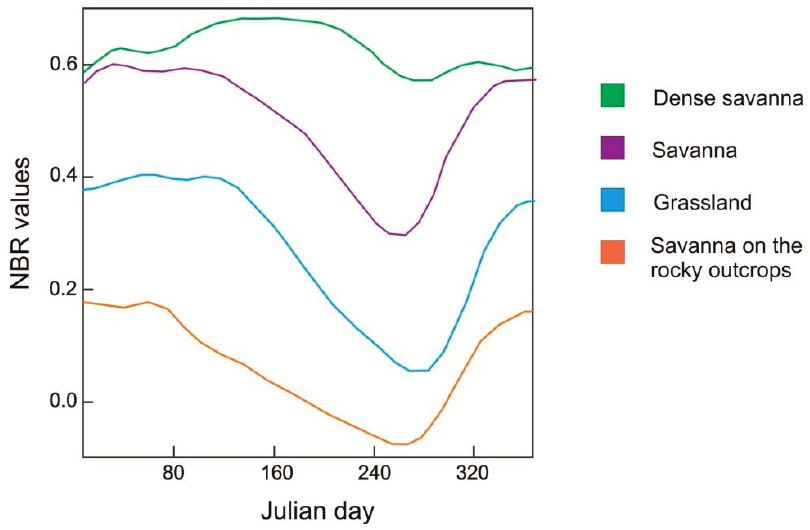
Figure 15. Mean annual curves of the savanna types: Savanna on rocky outcrop, Grassland, Savanna and Dense Savanna Woodland. The mean phenology was calculated from a 12-year